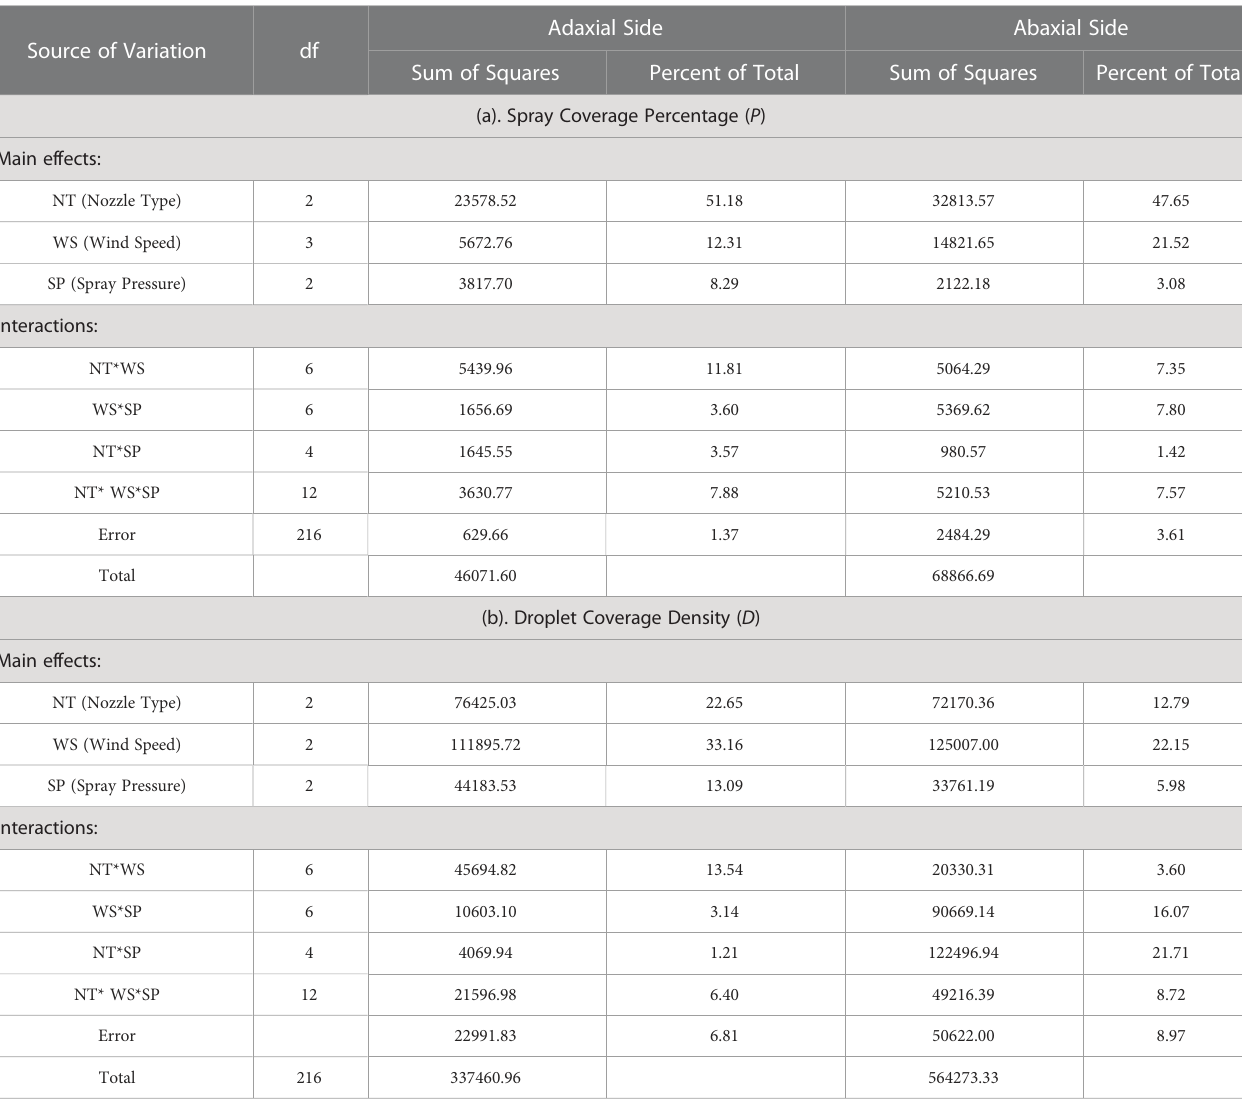
Source of Variation